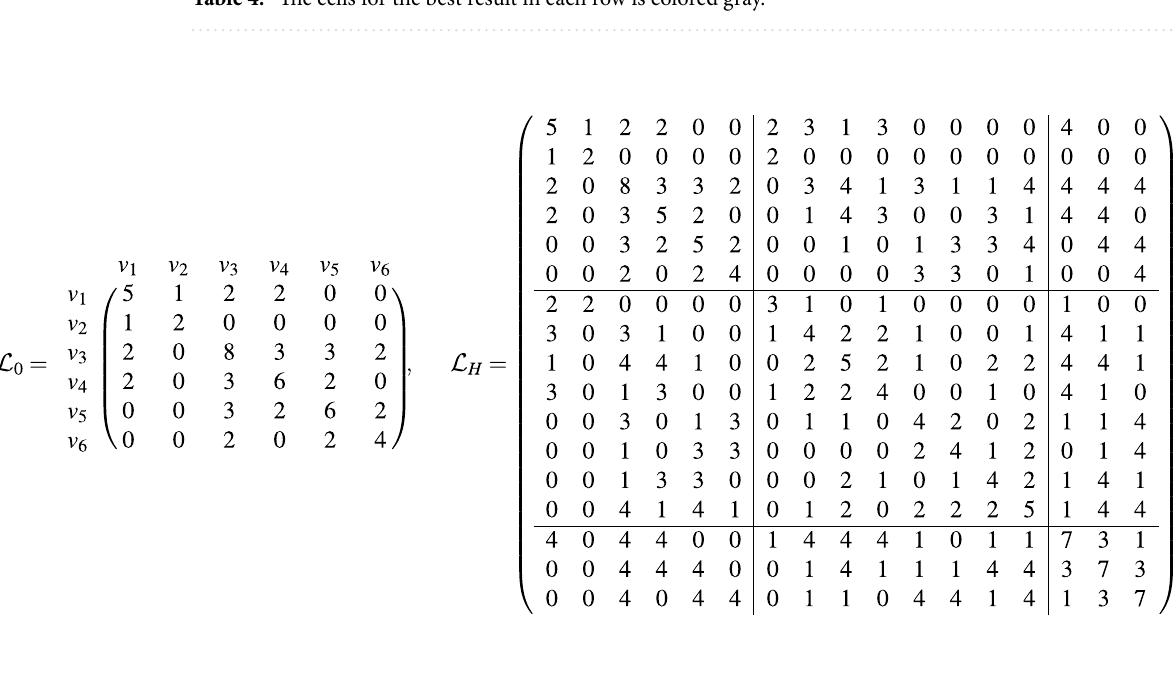
Table 4. The cells for the best result in each row is colored